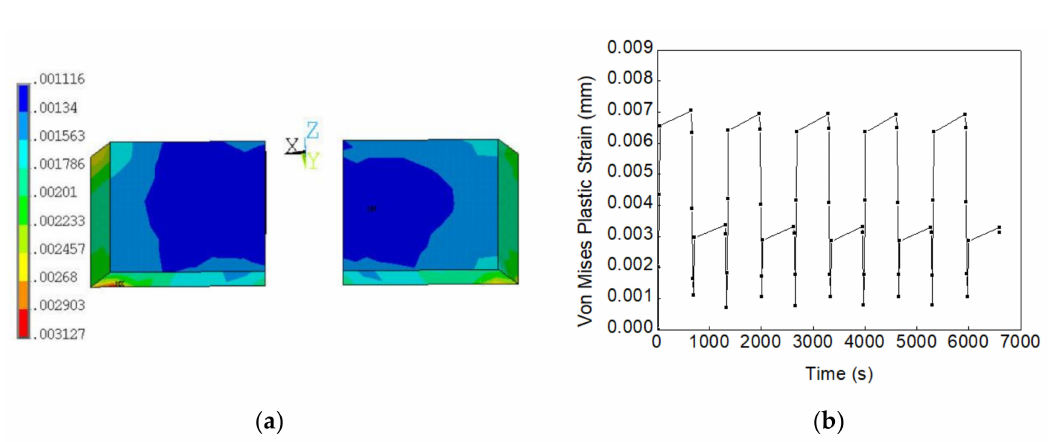
Figure 11. ( a ) Von Mises plastic strain distribution of void-free solder joints under thermal shock test; ( b ) Von Mises plastic strain of void-free solder joints vs.